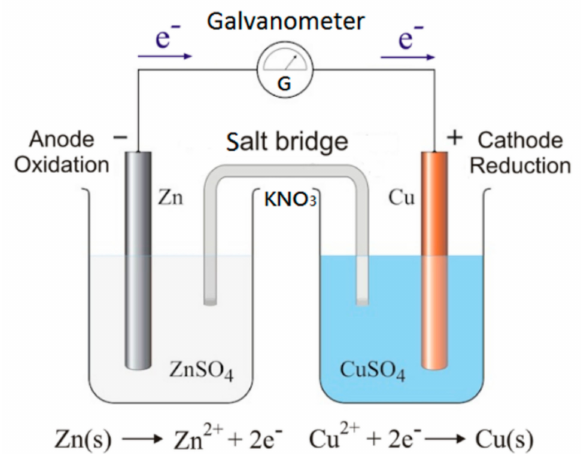
Figure 3. Operating principle of the Daniell cell’s redox